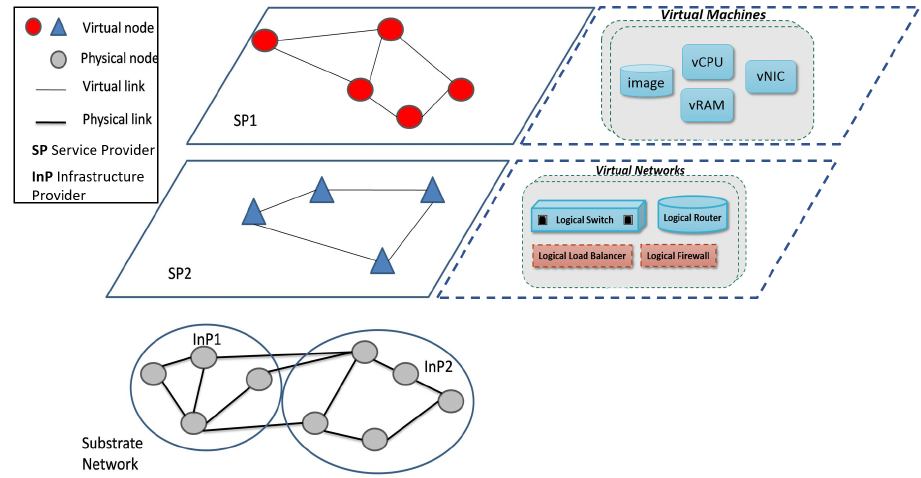
Figure 1. Network virtualization